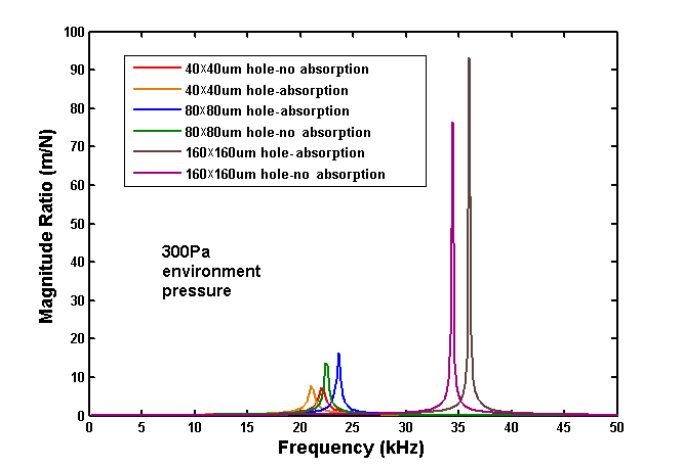
Figure 11. Effect of a 10% mass increase on the frequency response of three